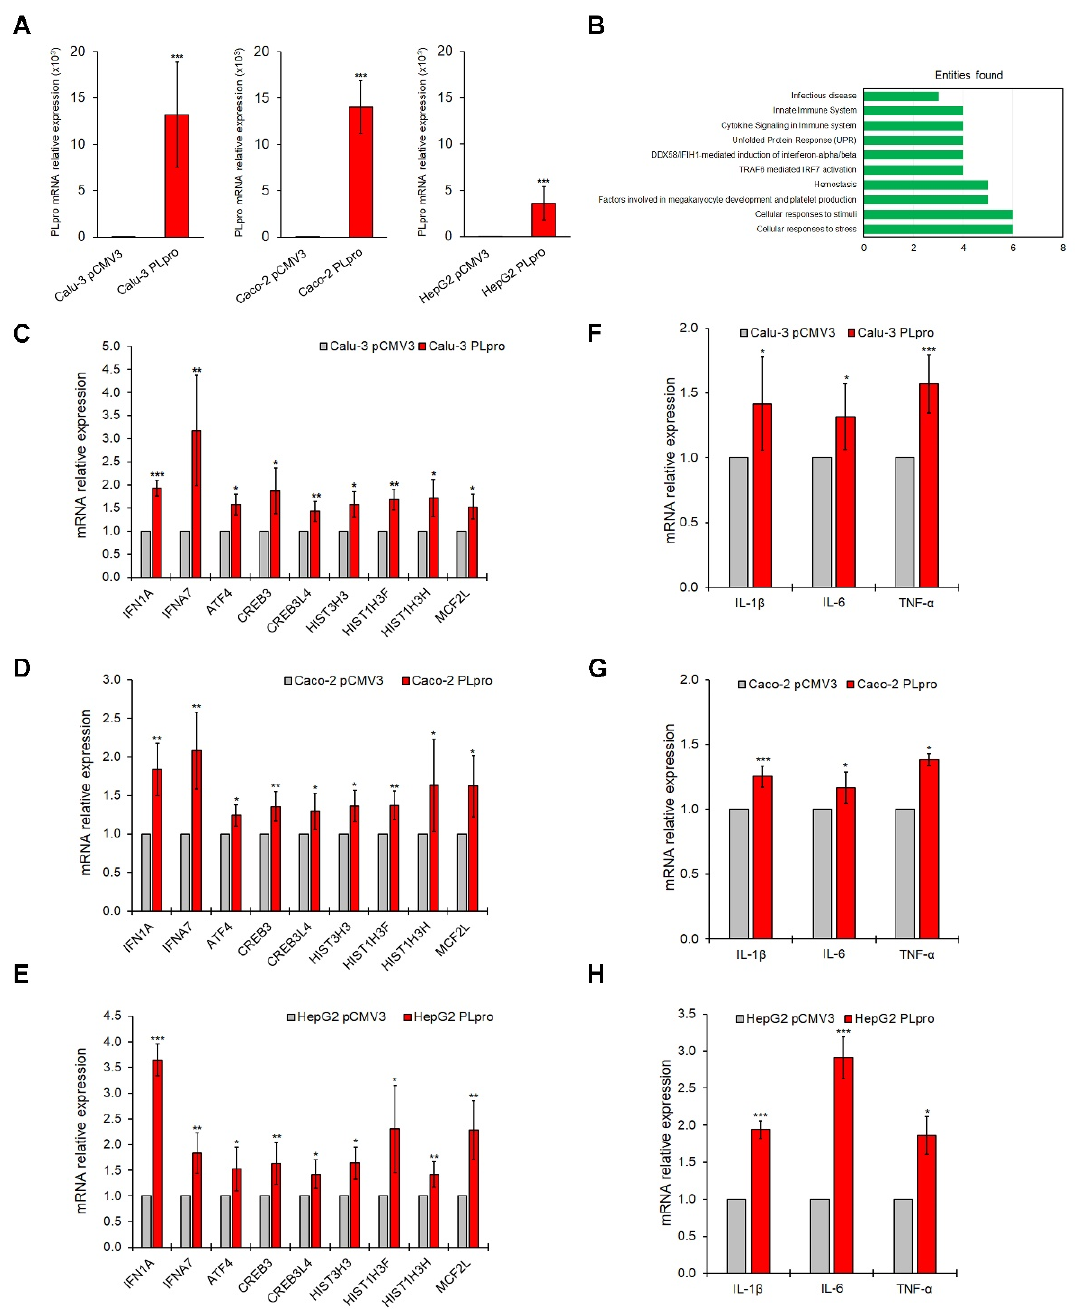
Figure 1. PLpro expression up-regulates genes of IFN pathways and pro-inflammatory cytokines in epithelial cells. ( A ) PLpro mRNA expression in Calu-3, Caco-2 and HepG2 cells after transfection with plasmid for PLpro (PLpro) or empty vector (pCMV3). ( B ) Bar plots of the 10 most abundant pathways for commonly up-regulated genes investigated in Calu-3, Caco-2 and HepG2 cells after transfection with plasmid for PLpro (PLpro) or empty vector (pCMV3). Relative mRNA expression of IFNA1, IFNA7, ATF4, CREB3, CREB3L4, HIST3H3, HIST1H3F, HIST1H3H, MCF2L genes measured by qRT-PCR in Calu-3 ( C ), Caco-2 ( D ), and HepG2 ( E ) cells transfected with plasmid for PLpro (PLpro) or empty vector (pCMV3). Relative mRNA expression of IL-1 β , IL-6 and TNF- α genes measured by qRT-PCR in Calu-3 ( F ), Caco-2 ( G ), and HepG2 ( H ) cells transfected with plasmid for PLpro (PLpro) or empty vector (pCMV3). Data are the mean ± SD of three independent experiments repeated at least in triplicate. Data were analyzed by 2-tailed t -tests, * p < 0.05, ** p < 0.01, *** p <